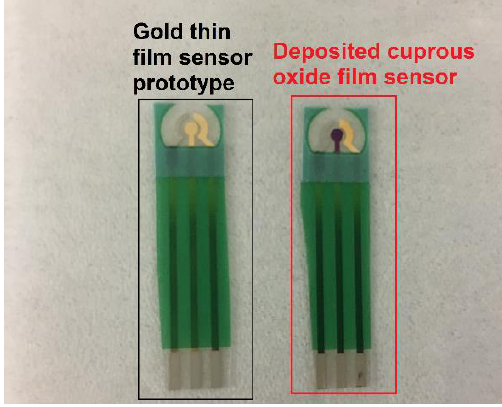
Figure 1. Comparison of gold sensor prototype and prepared cuprous oxide film sensor.